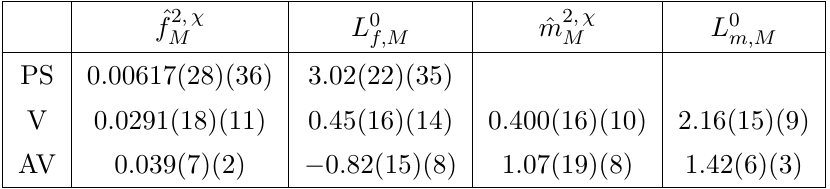
Table 10. Coe(cid:14)cients appearing in eqs. (4.13) and (4.14), determined by using the results of the global (cid:12)t described in the main text. The results are compatible with those obtained with the alternative (cid:12)t process in table 8, except for the coe(cid:14)cient L 0 f; AV